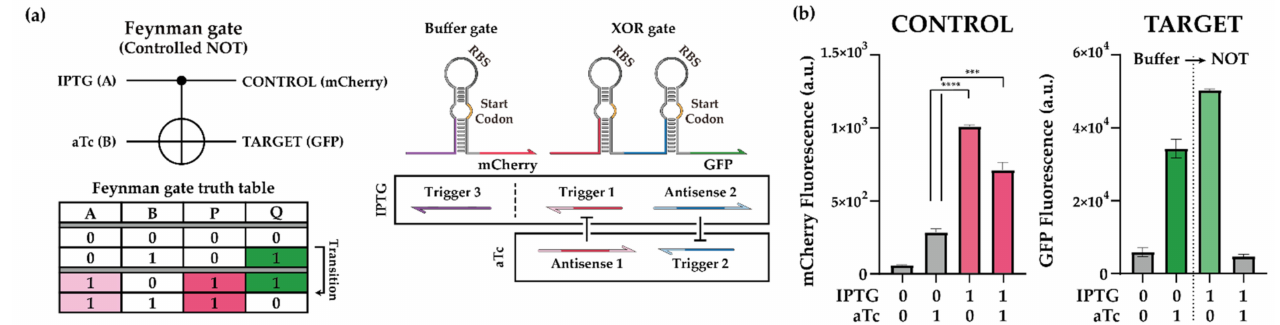
Figure 5. Demonstration of toehold-switch-based Feynman gate. ( a ) Schematic of the Feynman gate. Truth table of the Feynman gate indicated the ON and OFF states for each of the binary calculators depending on the combination of inducer molecules. Transition denotes the functional transition of a Buffer gate to a NOT gate. IPTG and aTc were used as input signals. Trigger and antisense RNAs under the same inducer control are shown in boxes. ( b ) Performance of Feynman gate. T7 RNA polymerase was induced with the pretreatment of 1% ( w / w ) arabinose in E. coli BL21 AI strain. RNAs of Feynman gate were induced by 1 mM IPTG and 200 ng/mL aTc. GFP and mCherry fluorescence were measured on flow cytometry. Cellular autofluorescence was subtracted in all cases. Autofluorescence level was measured from cells not bearing a GFP- or mCherry-expressing plasmid. Statistical analysis was performed for comparing each state of the Feynman gate. (Two-tailed Student’s t -test; *** p < 0.001; **** p < 0.0001; Error bars indicate ± SD from three biological